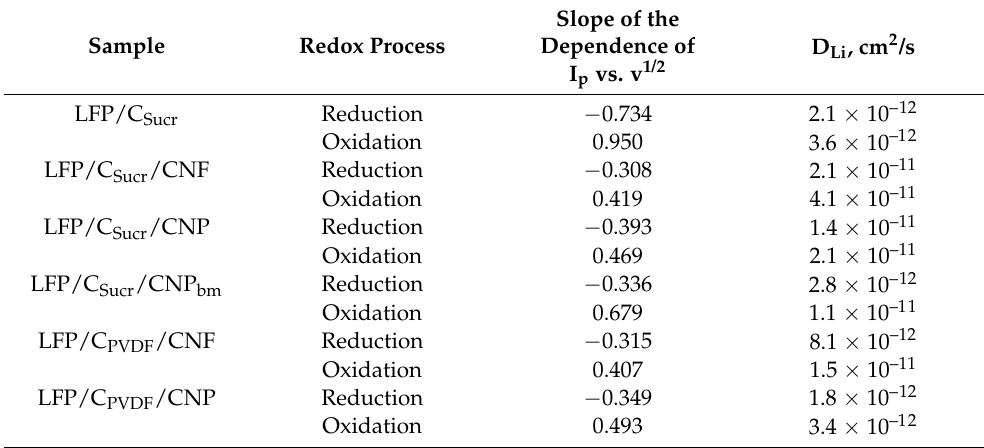
Table 3. The calculated Li + diffusion coefficients for some composites of LFP and carbon nanomateri-